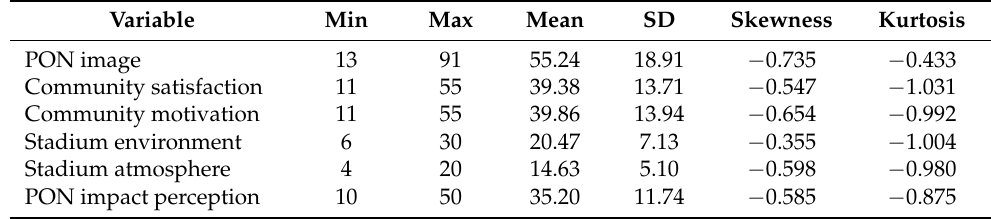
Table 2. Descriptive analysis and normality of the